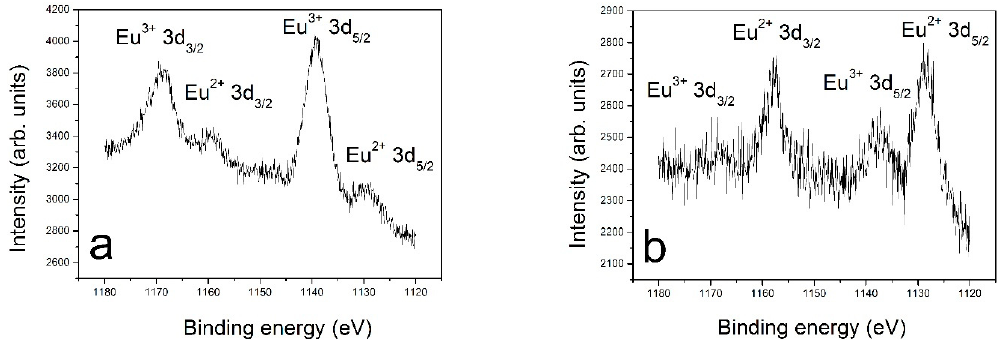
Figure 3. The Eu 3d high resolution XPS spectrum of Eu-4 mol% sialon phosphor of the as-received powder ( a ) and after 2 min etching of Ar ions ( b ).